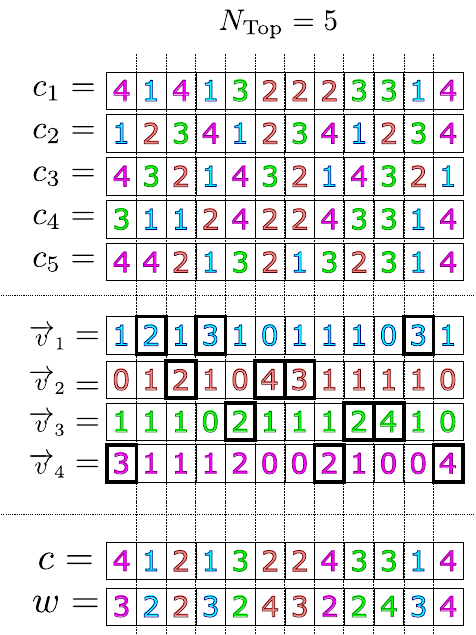
Figure 2. Computation of the representative individual ( c ) and its genetic relevance ( w ).